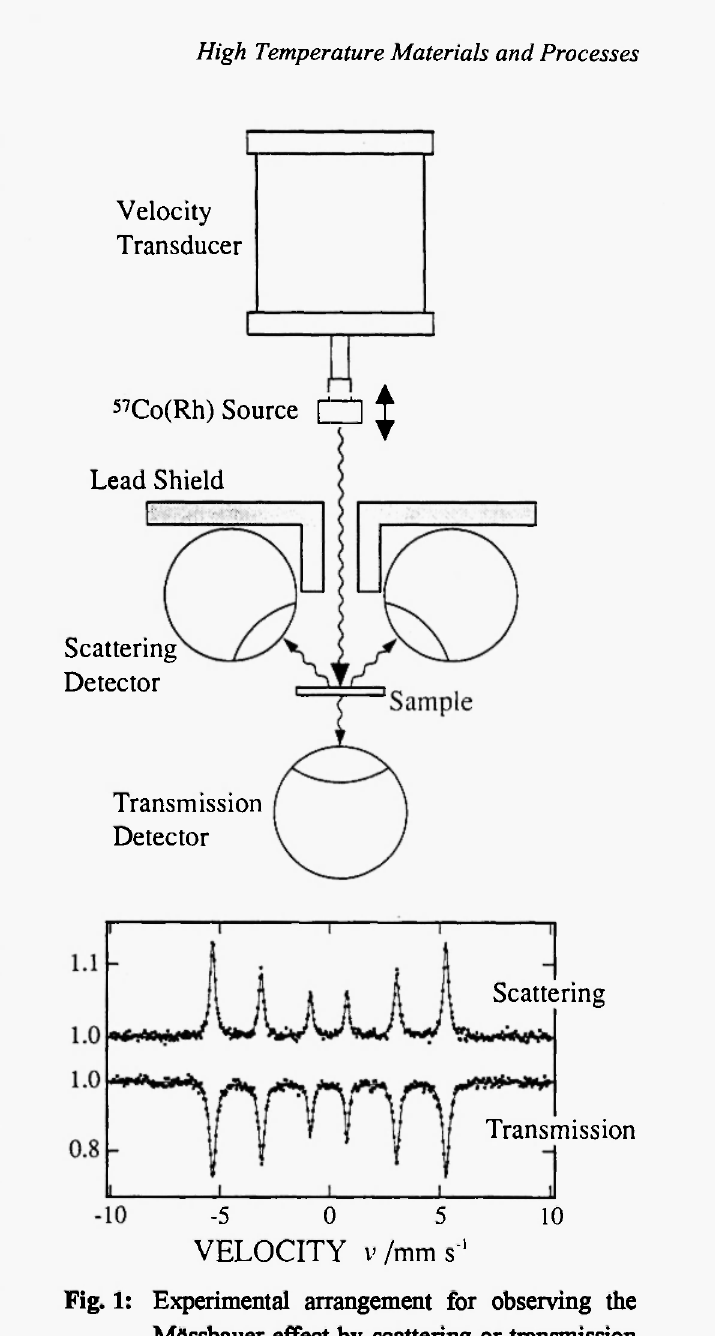
Fig. 1: Experimental arrangement for observing the Mössbauer effect by scattering or transmission for thin samples. The scattering experiment can also be performed on a thick sample. Spectra obtained by transmission and scattering geometry from a ferromagnetic α-Fe at room temperature. S7 Co in Rh at room temperature is used as a standard single line